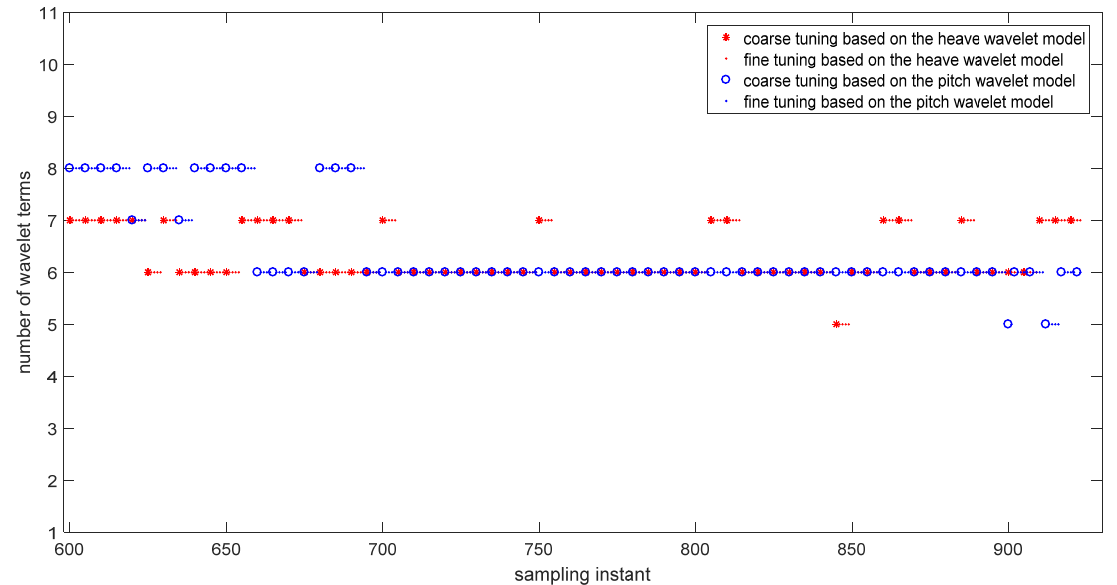
Figure 12. The structure of the CFT-FGWN changing over time based on the simulation data.